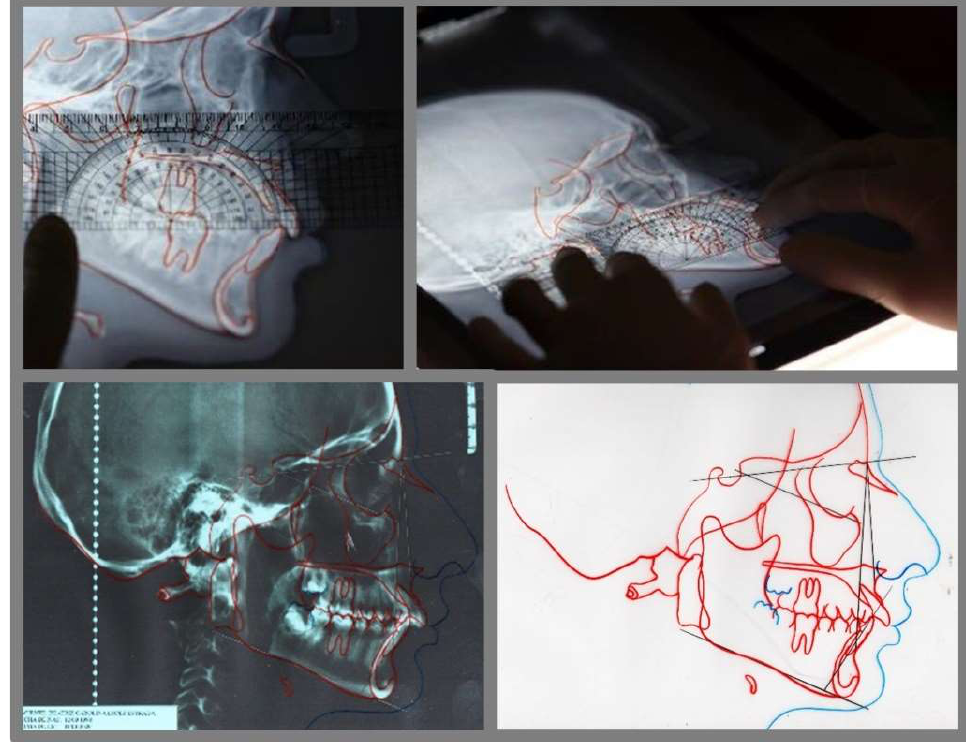
Figure 4. Manual tracing using printed radiograph and tracing ruler.